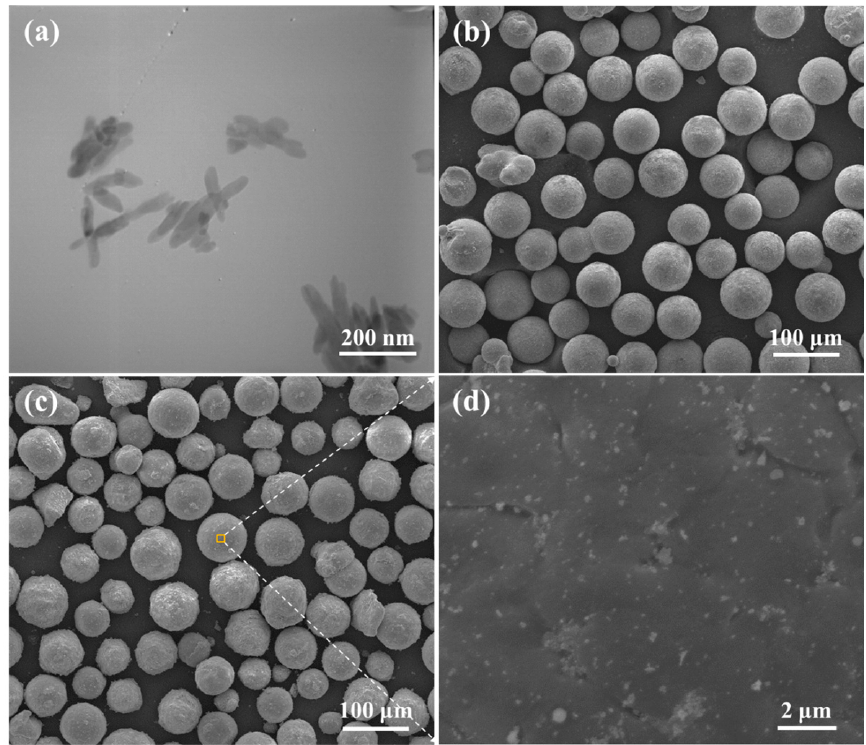
Figure 9. The raw and mixed powder: ( a ) transmission electron microscopy (TEM) image of the raw HA powder; ( b ) SEM image of the raw Mg-3Zn powder; ( c ) SEM image of the Mg-3Zn/5HA mixed powder and ( d ) an enlarged view of marked area in Figure 9c.